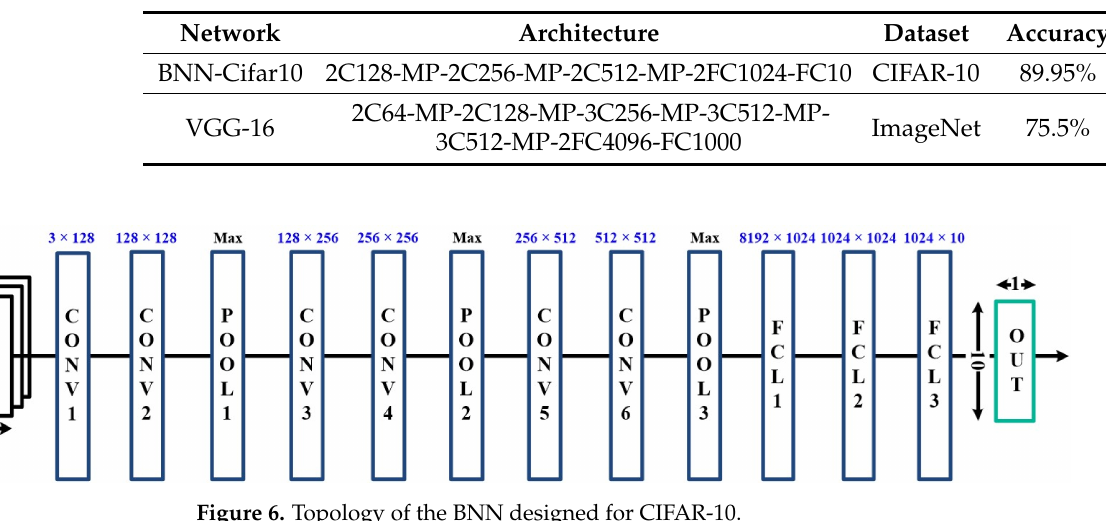
Table 2. Architectures of the network topologies used to evaluate performance. MP, max pooling; C, CONV.